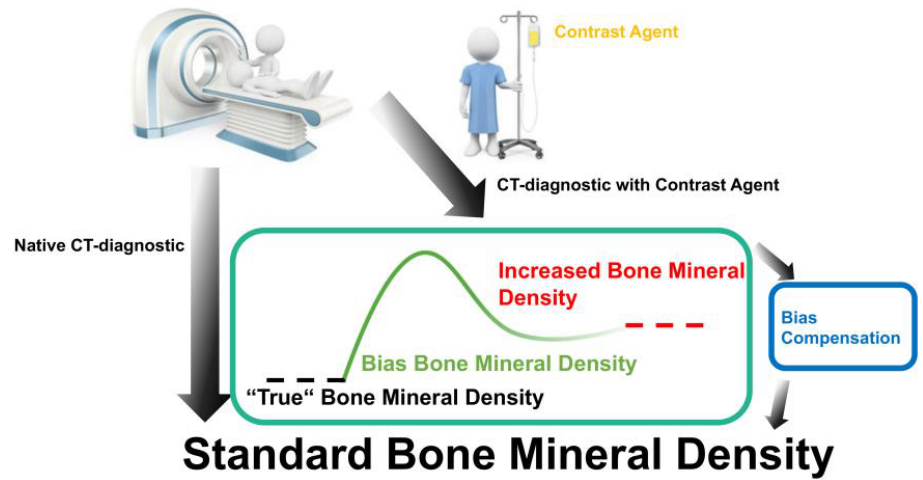
Figure 5. Difference of bone mineral density (BMD) between the bone quality of control subjects (normal), and osteopenia as well as osteoporosis patients. The BMD (mg/cm 3 ) is shown on the y-axis, bone quality is presented on the x-axis. Median values are shown. Note the increased BMD in patients.